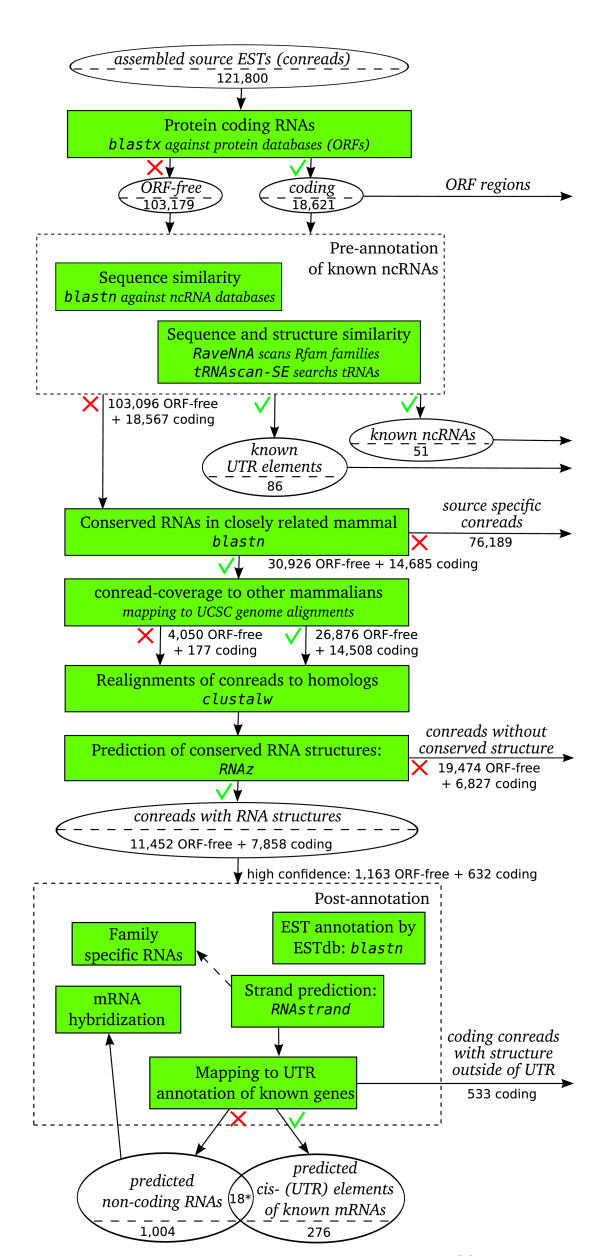
The flowchart illustrates the basic functionality of the EST2ncRNA pipeline. Furthermore, the number of PigEST conread candidates are shown for each step. The pipeline detects known and novel candidates of functional non-coding RNAs as well as cis-regulatory elements from large assembled EST datasets. In summary, the pipeline consists of four main steps: (1) pre-annotation of known ncRNAs, (2) homology search in other organisms, (3) prediction of thermodynamic stable and conserved RNA structures, and (4) post-annotation. A method to detect family specific RNAs in the post-annotation is RNAmicro for instance. The candidates for mRNA hybridization predicted by RNAduplex are not included in the publication. The sign × indicate sequences not matching a given step in the pipeline. The sign √ indicate the sequences which were matched. (*) 18 ORF-free conreads contain two independent RNA structures of which only one is similar to an human UTR. Therefore, these conreads are counted twice.